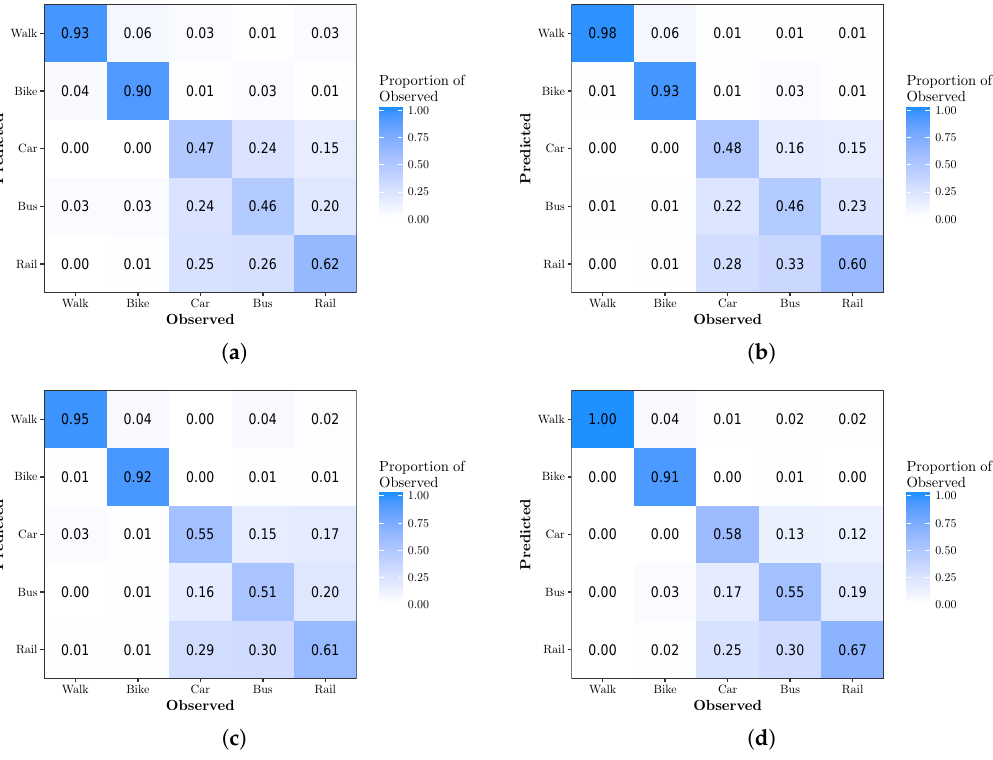
Figure 2. Matrices representing the proportion of observed modes predicted in each category using movelets of a specified time length. ( a ) 30 s; ( b ) 60 s; ( c ) 90 s; ( d ) 120